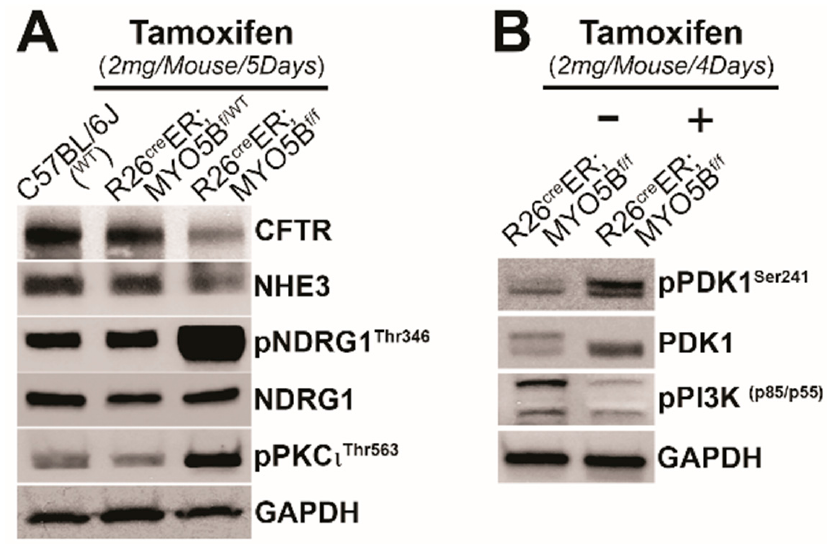
Figure 9. Immunoblots of ion transporters and phosphorylated kinases in C57BL/6J (WT), R26 Cre ER;MYO5B f/wt , or R26 Cre ER;MYO5B f/f mice treated with tamoxifen (2 mg/day/mouse) for 4–5 days. ( A ) Immunoblots of CFTR, NHE3, NDRG1, pNDRG1 Thr346 , and pPKC ι Thr563 in tamoxifen (2 mg/mouse/day)-treated C57BL/6J (WT), R26 Cre ER;MYO5B f/wt (Heterozygous) or R26 Cre ER;MYO5B f/f (Homozygous) mouse jejunal lysates at day 5. ( B ) Immunoblots of PDK1, pPDK1 Ser241 and pPI3K p85 Tyr458 /p55 Tyr199 in jejunal lysates of R26 Cre ER;MYO5B f/f mice treated with or without tamoxifen (2 mg/mouse/day) for 4 day, vs. vehicle (corn oil). GAPDH was used as a loading control for both experiments. N = 3, independent experiments for each condition